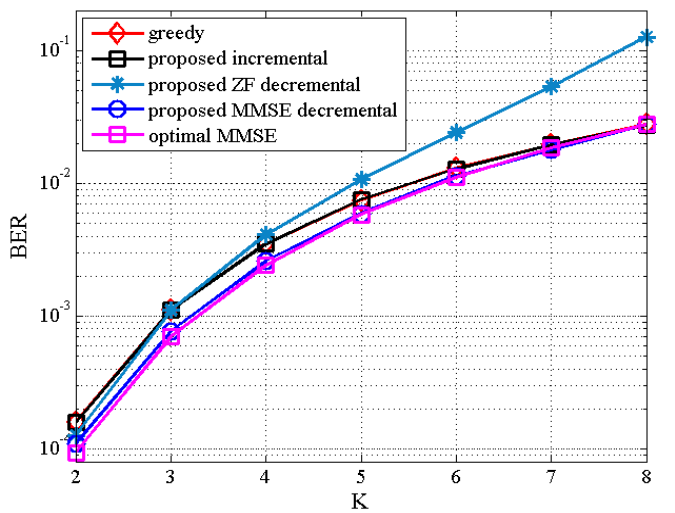
Figure 9. BER the proposed TAS selection algorithm for ( 8, N S , K ) MU–STLC system with N S = K under SNR = 12 dB.